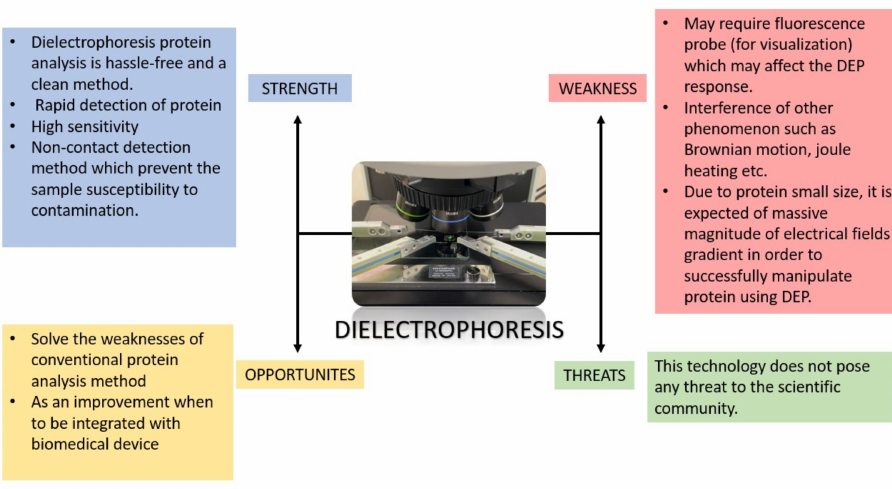
Figure 12. Detailed SWOT analysis of